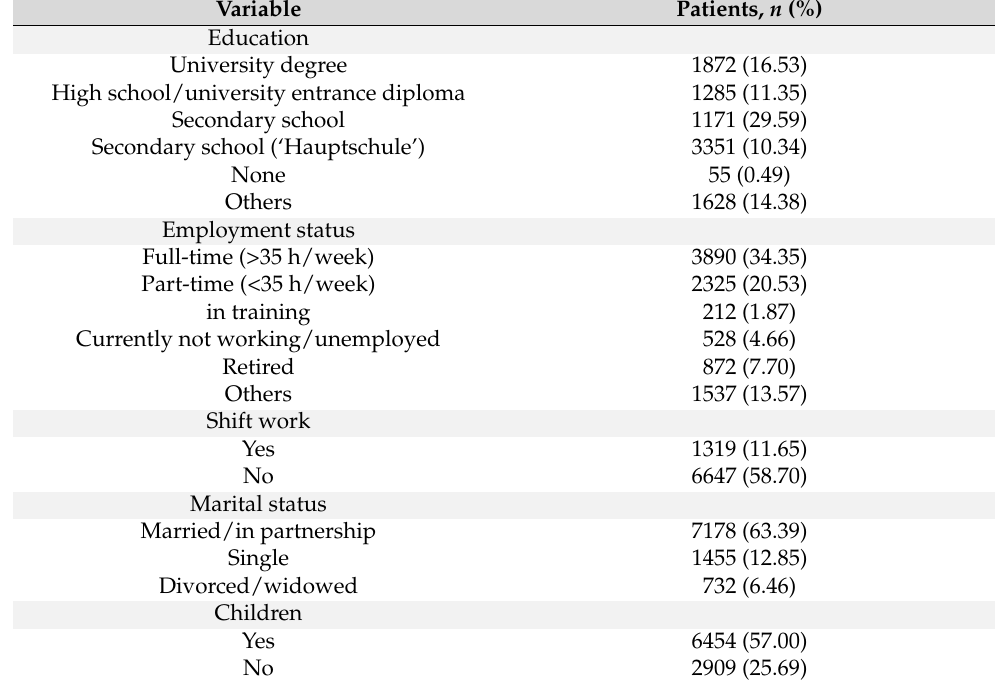
Figure 1. Age ( A ), initial weight ( B ), and initial BMI ( C ) of patients when registering for zanadio . Depicted are means (black dot) and distributions (boxplot, violin plot) separately for male and female patients. Table 2. Demographics of patients registered between November 2020 and April 2022 (BMI 30–45 kg/m 2 ).